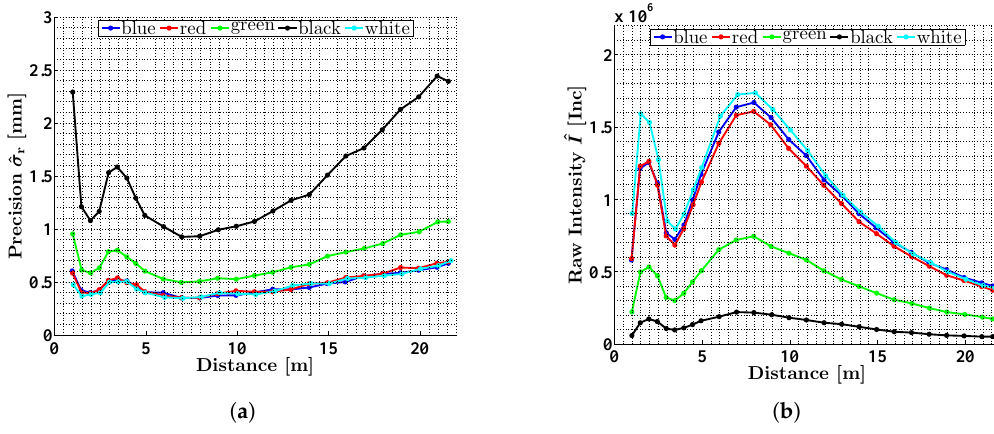
Figure 10. Precision ˆ σ r ( a ) and intensity ˆ I ( b ) of the distance measurements of the Z + F Profiler 9012A as a function of distance between sensor and object. The scans were carried out on colored planar targets (mirror speed: 50 rps, scan rate: 1016